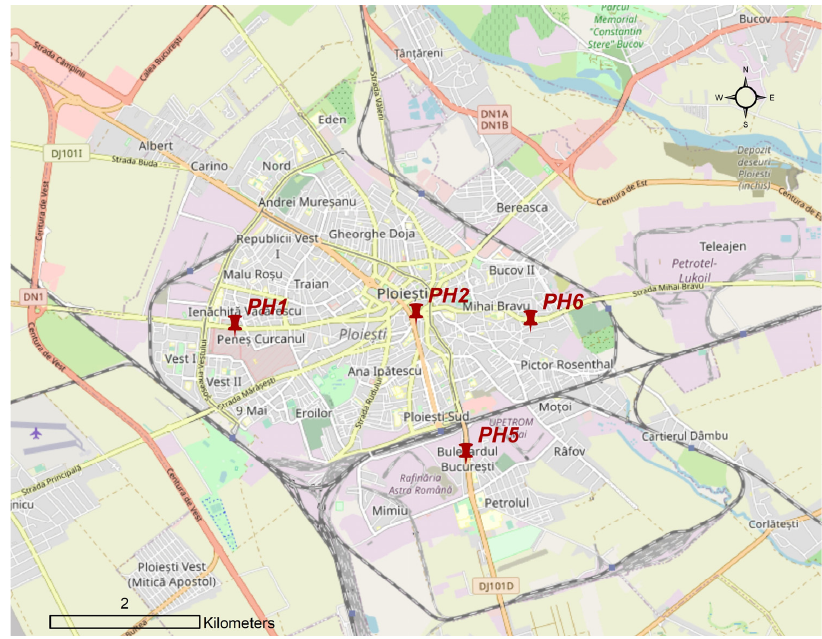
Figure 1. Map of Ploiesti city presenting the sampling points near the official monitoring stations from the Romanian national network (RNMCA)—https://calitateaer.ro/public/home-page/?__locale=en (accessed on 19 February 2023).